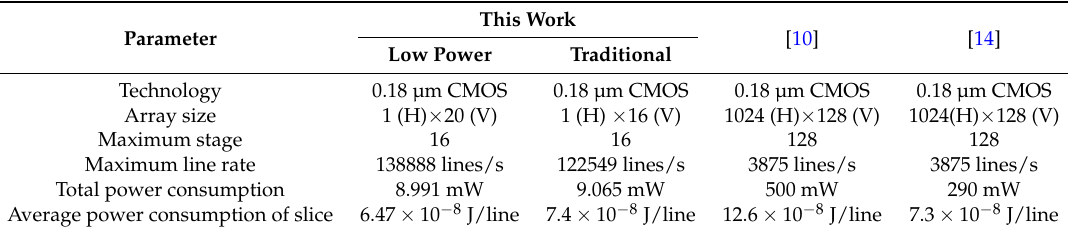
Table 2. Comparisons of some main parameters of the two kinds of image sensor chains with prior works. (H-Horizontal,